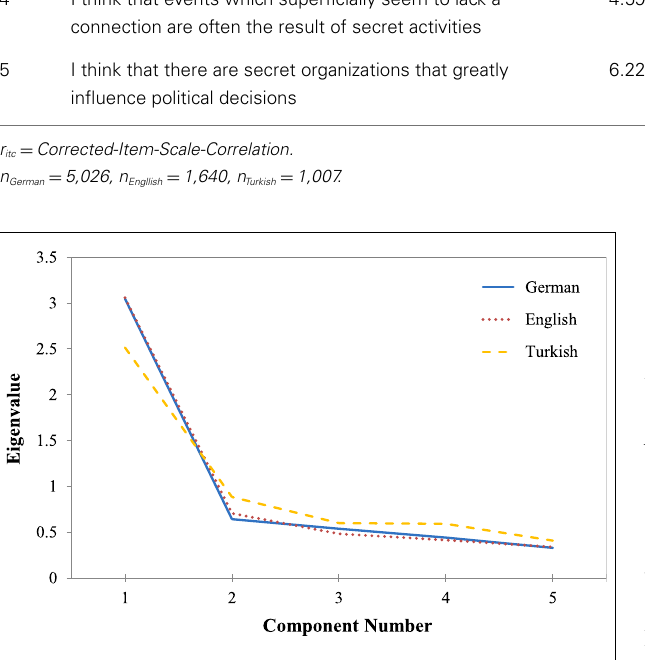
RMSEA falling within the range of well-fitting models and the TLI only falling very slightly short of the value of 0.95 (Hu and Bentler, 1999). Comparing the SE model with the less